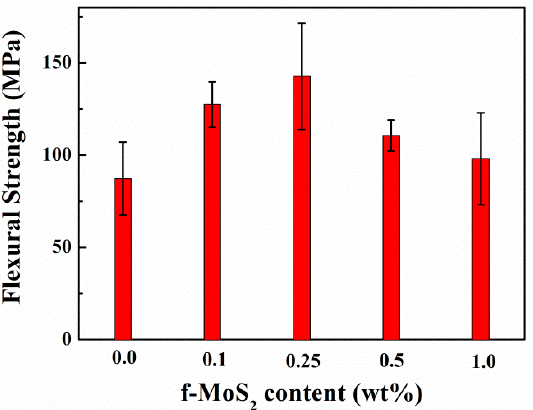
Figure 10. Flexural strength vs. f-MoS 2 content of the Epoxy and Epoxy/f-MoS 2 nanocomposites.